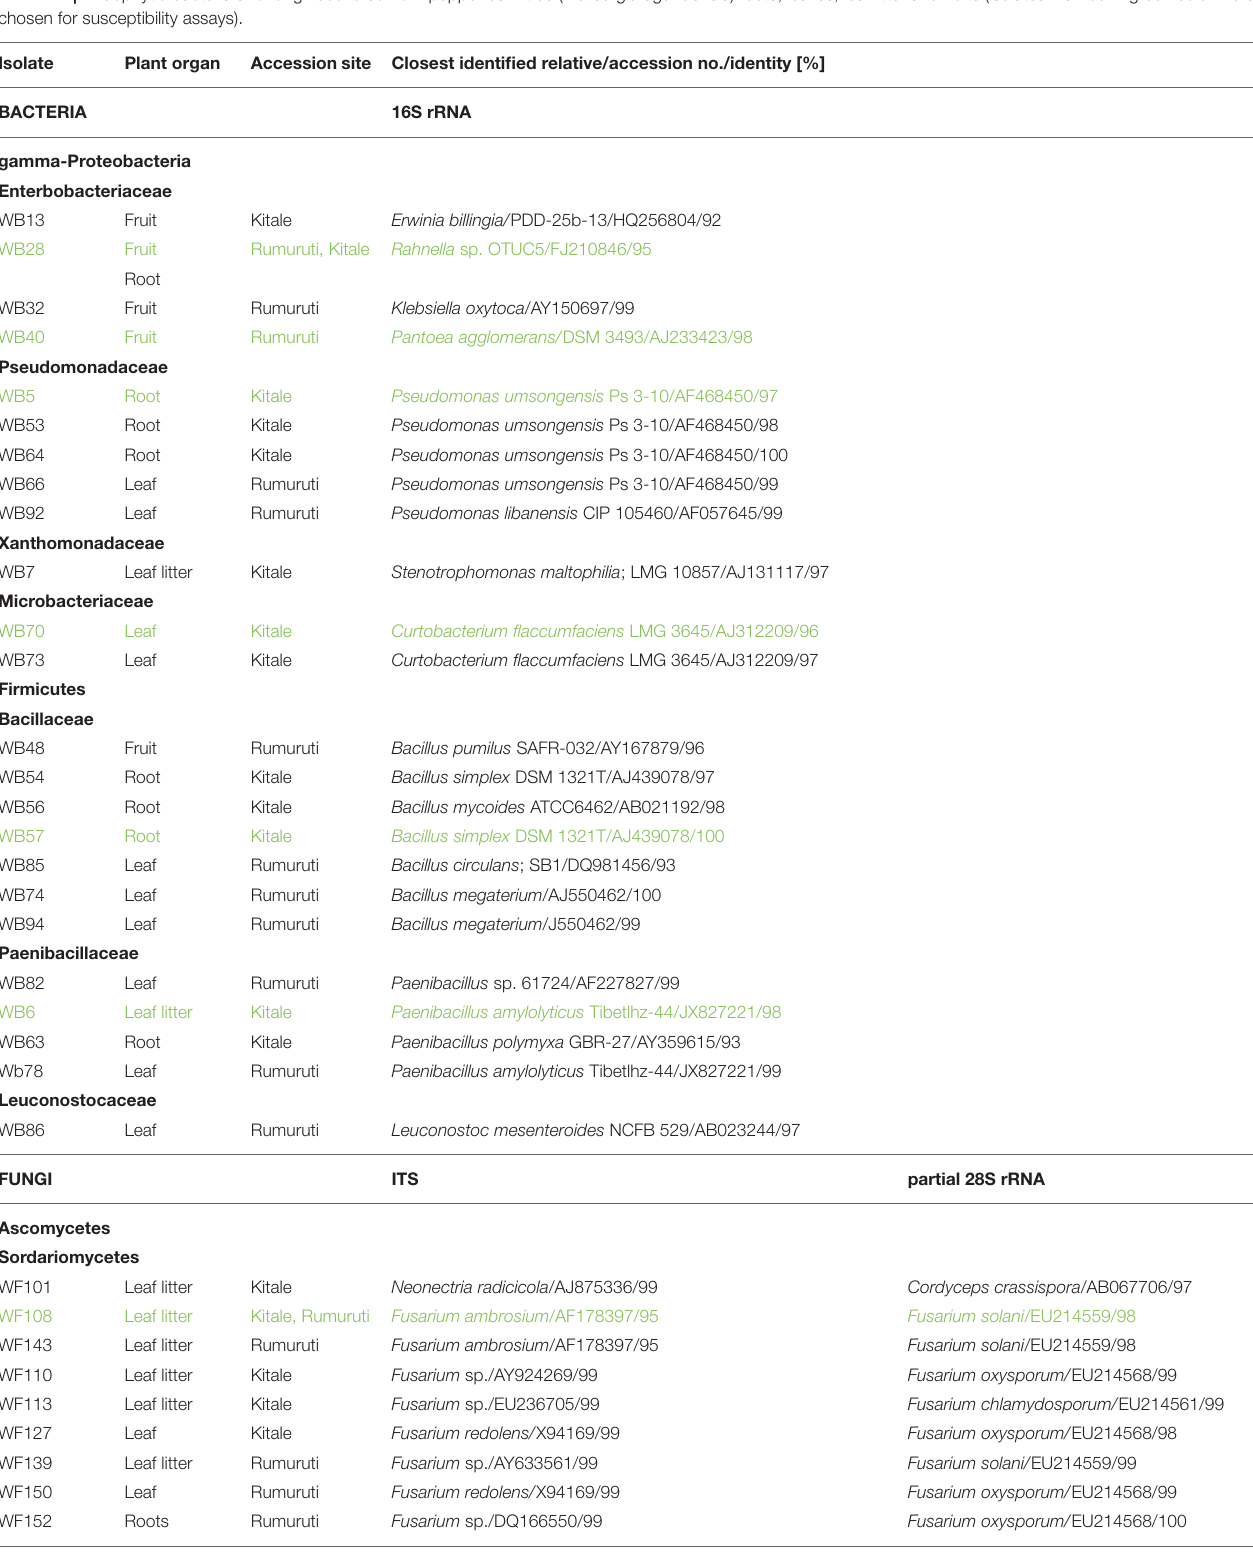
TABLE 1 | Endophytic bacteria and fungi recovered from pepper bark tree ( Warburgia ugandensis ) roots, leaves, leaf litter and fruits (isolates marked in green color were chosen for susceptibility assays). Isolate Plant organ Accession site Closest identified relative/accession no./identity